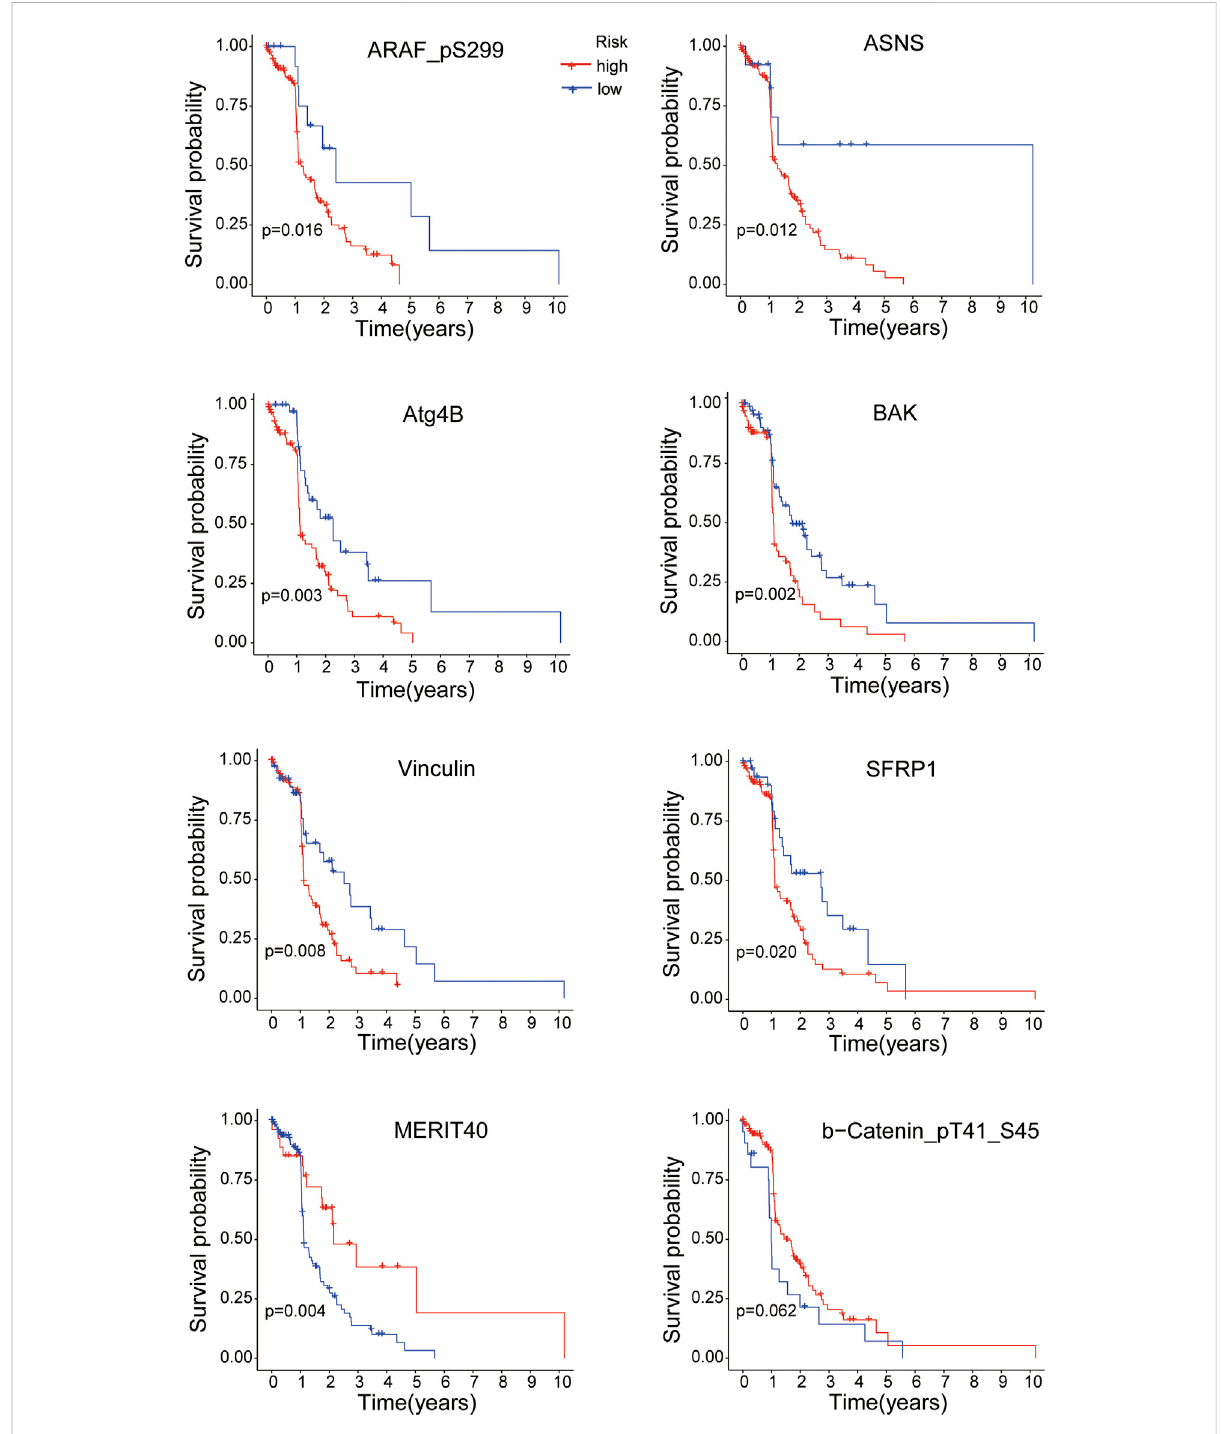
FIGURE 8 The overall survival analysis of the 8 proteins expressions in EC